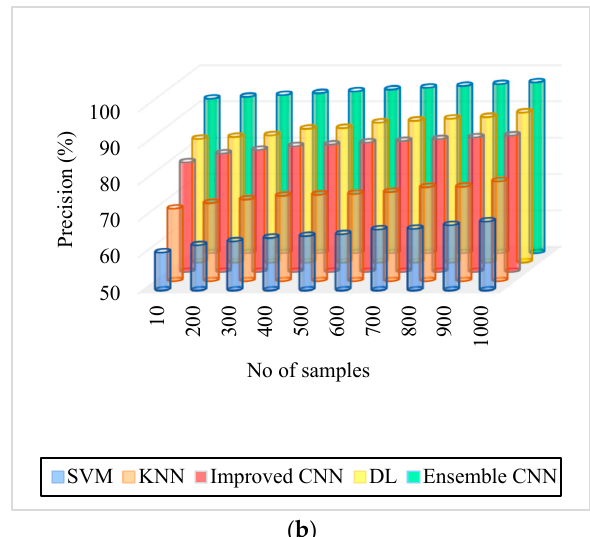
Figure 6. Precision. ( a ) IDRiR and ( b ) Messidor.